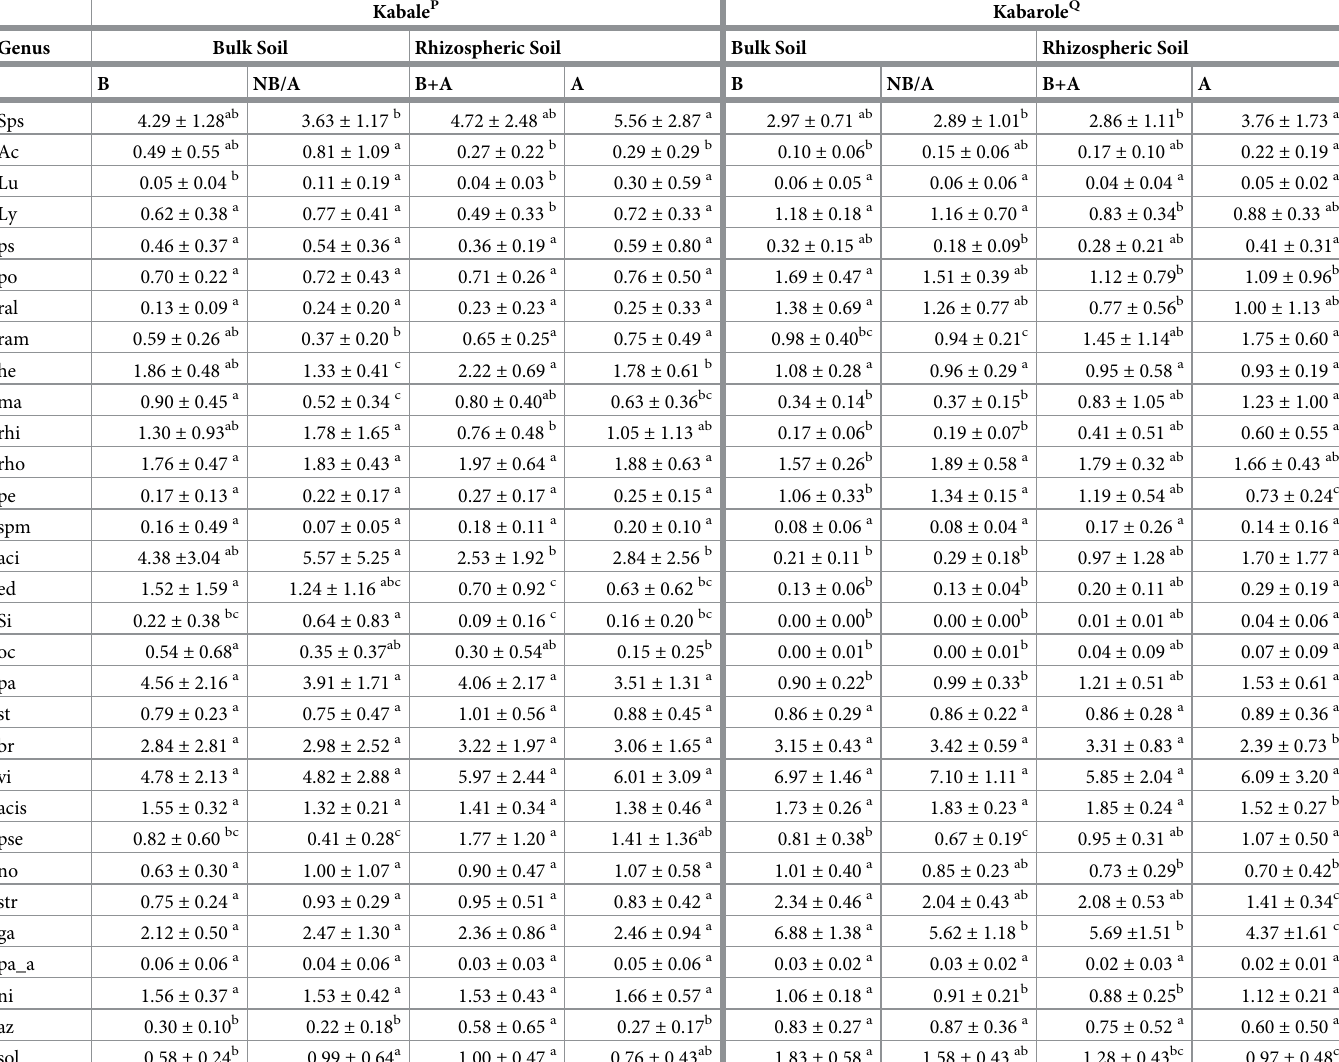
Table 3. Percentage abundance ( � 0.2%) of various bacterial genera detected in bulk and rhizospheric soil.